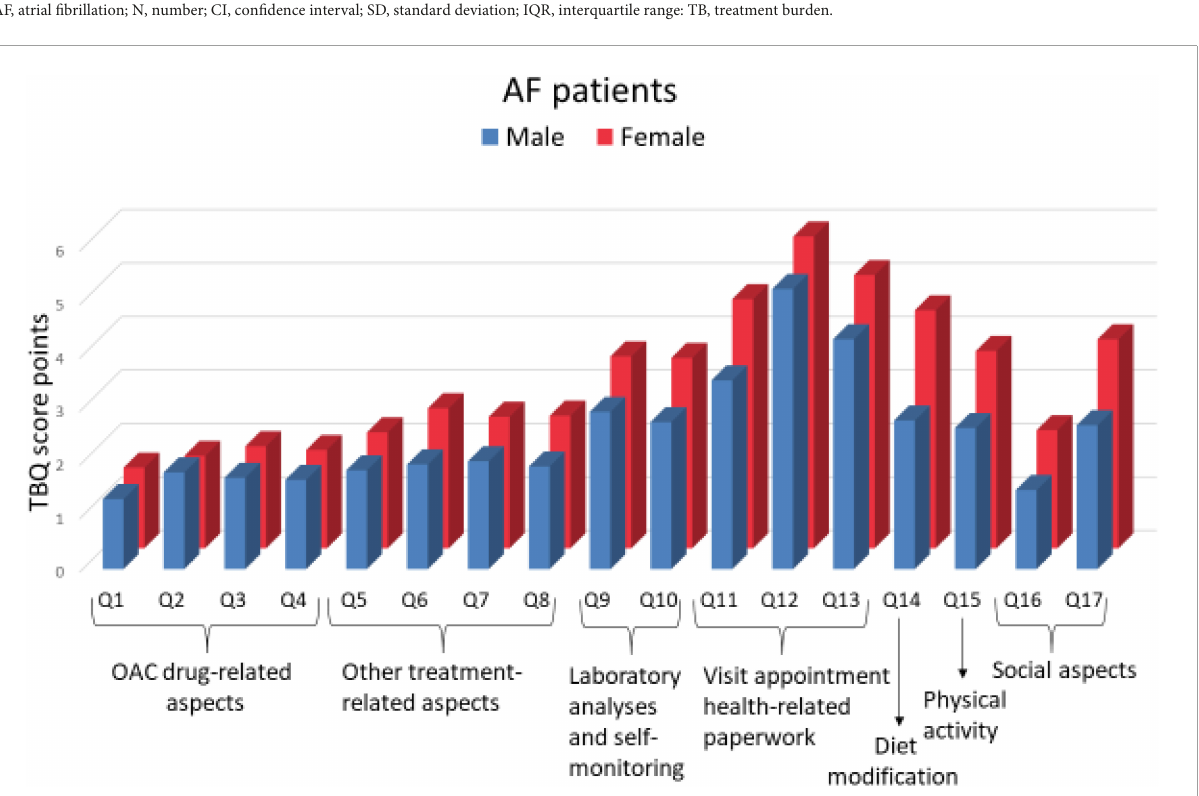
significantly higher EQ-5D score for mobility, pain/discomfort, and anxiety/depression (all P ≤ 0.002); see Supplementary Table 2 . With increasing the TB mean score, the mean EQ-5D QOL score significantly increases (i.e., QoL was lower) in both sexes. In addition, the anxiety/depression question score